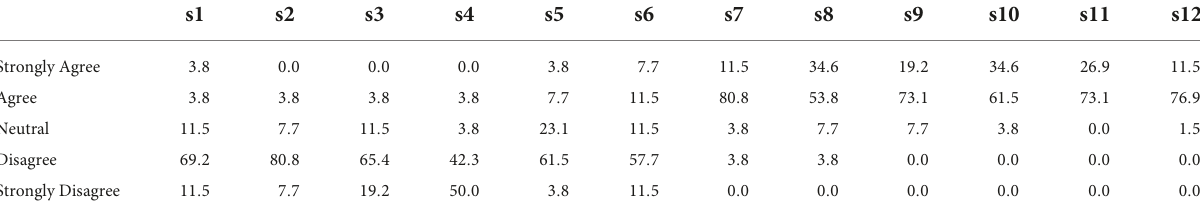
TABLE 7 Percentage of specific options for preservice mathematics teachers (%).